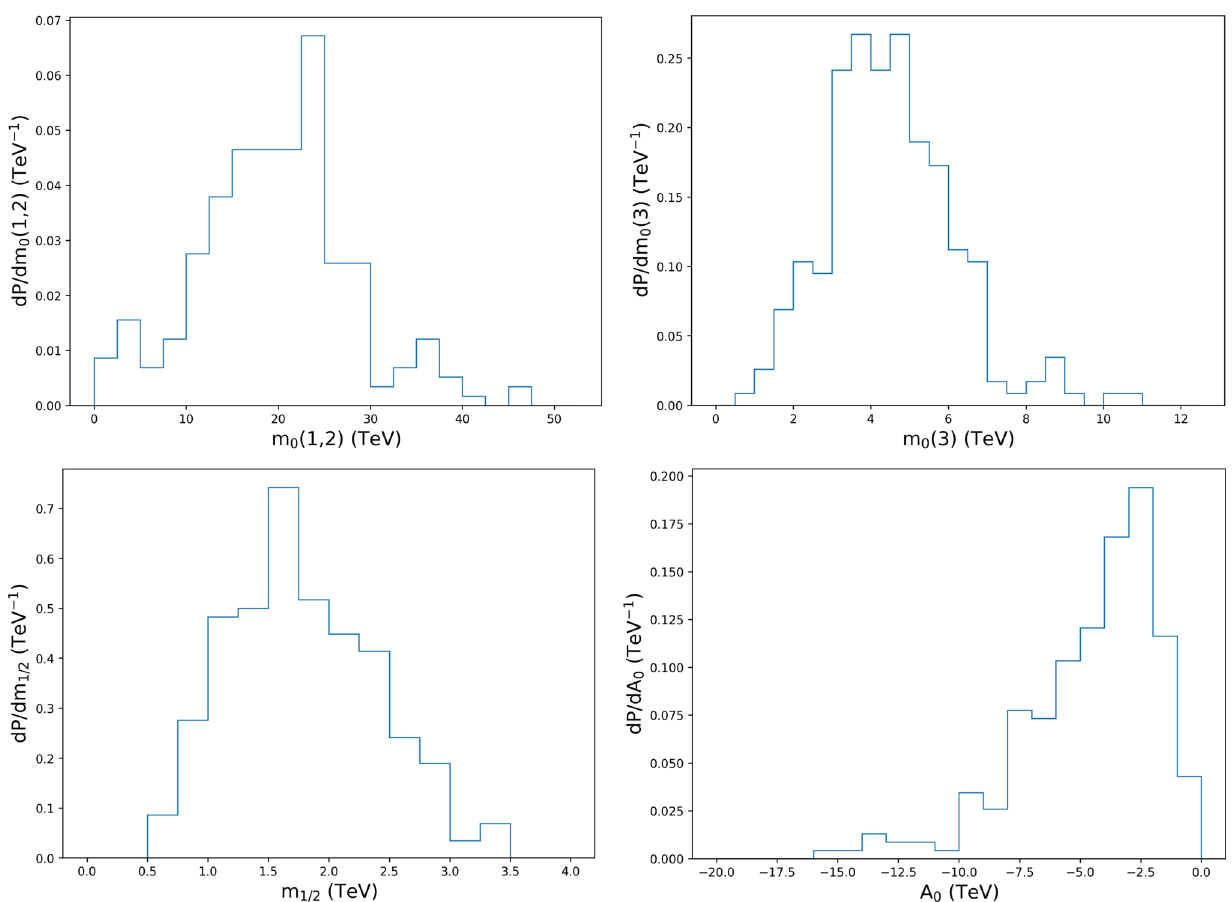
Fig. 5 Distribution of soft SUSY breaking terms in subset of landscape vacua with the NUHM3 model as low energy EFT and an n = 1 statistical draw. We show distributions in a m 0 ( 1 , 2 ) , b m 0 ( 3 ) , c m 1 / 2 and d A 0